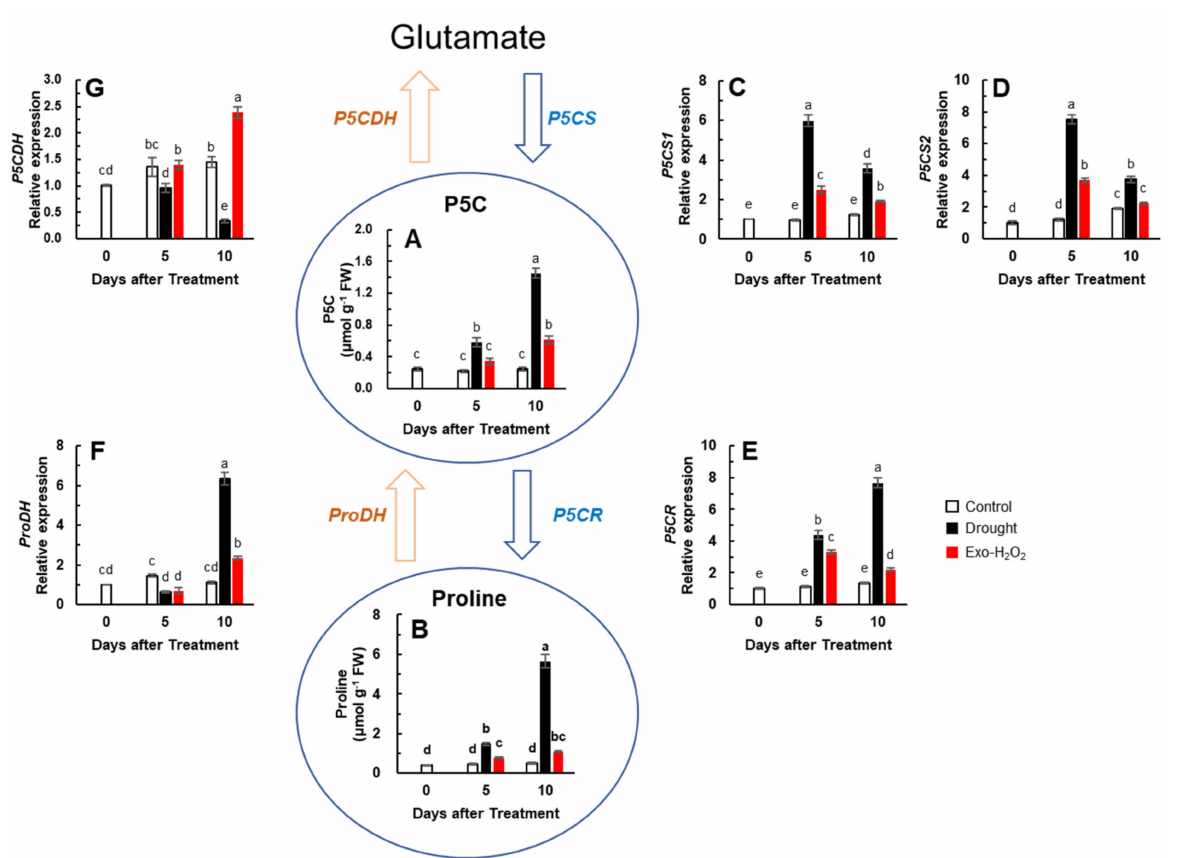
Figure 4. Changes in proline metabolism in the leaves of control, drought-, or exogenous H 2 O 2 (Exo-H 2 O 2 )-treated plants for 10 days. ( A ) Pyrroline-5-carboxylate (P5C) and ( B ) proline content, and expression of ( C ) P5C synthase 1 ( P5CS1 ), ( D ) P5CS2 , ( E ) P5C reductase ( P5CR ), ( F ) proline dehydrogenase ( ProDH ), and ( G ) P5C dehydrogenase ( P5CDH ). Results are represented as mean ± SE for n = 3. Different letters indicate values that are significantly different at p < 0.05 according to Duncan’s multiple range